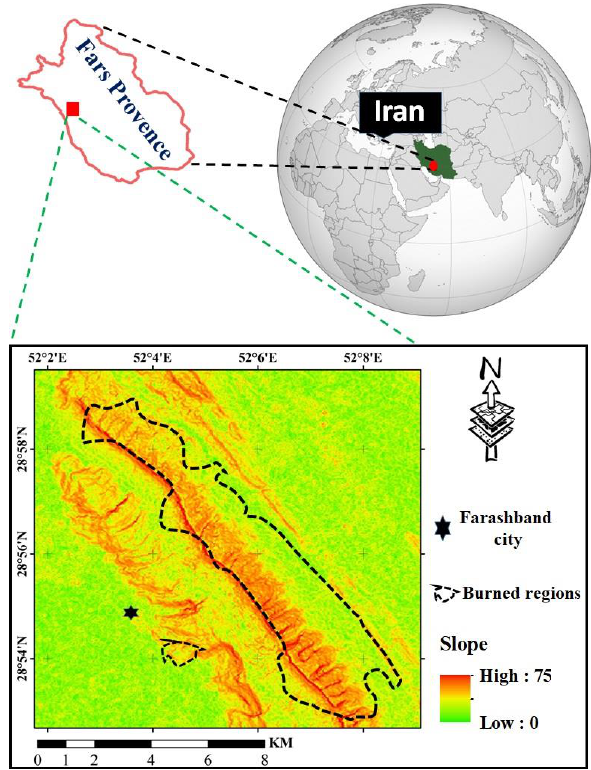
Figure 1. location of the study areas by the Slope model.